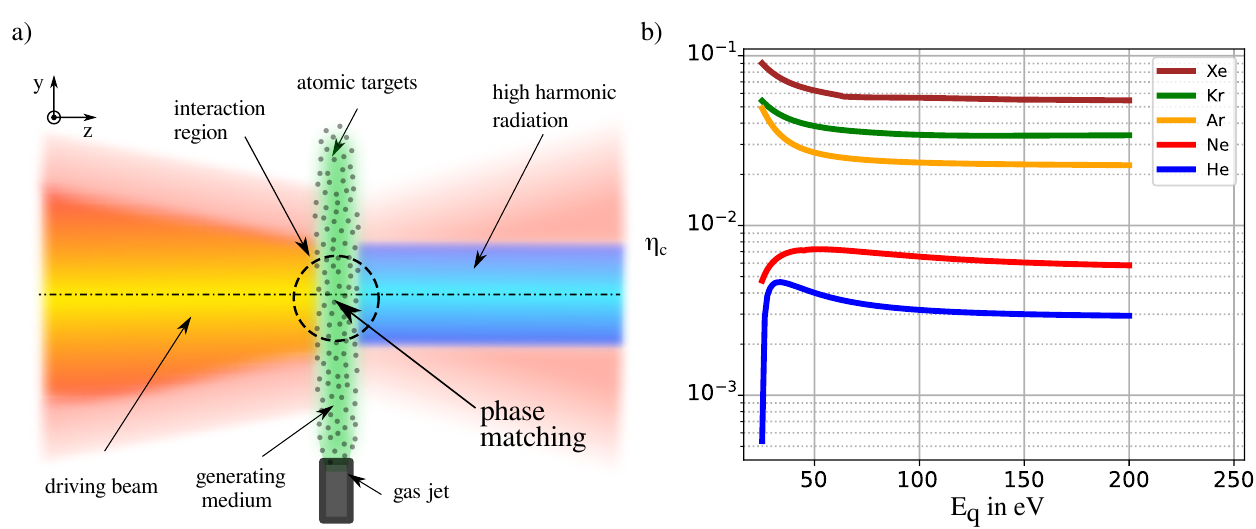
Figure 1. ( a ) HHG-setup: laser pulse (orange-red), atomic targets (gray), generating medium (green), high-order harmonic radiation (blue), gas-jet emitter (gray-black); and ( b ) critical ionization proba- bility η c (log scale) of commonly used noble gases with regard to the photon energy of the emitted harmonics E q at the fundamental laser wavelength of λ =